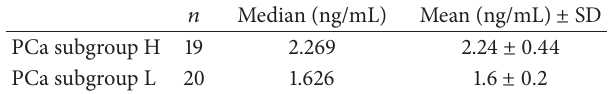
Table 2: Mean and median plasma CXCL12 concentrations in subgroup H (Gleason score > 7 including 4 + 3) were significantly higher than in subgroup L (Gleason score > 7 including 4 +